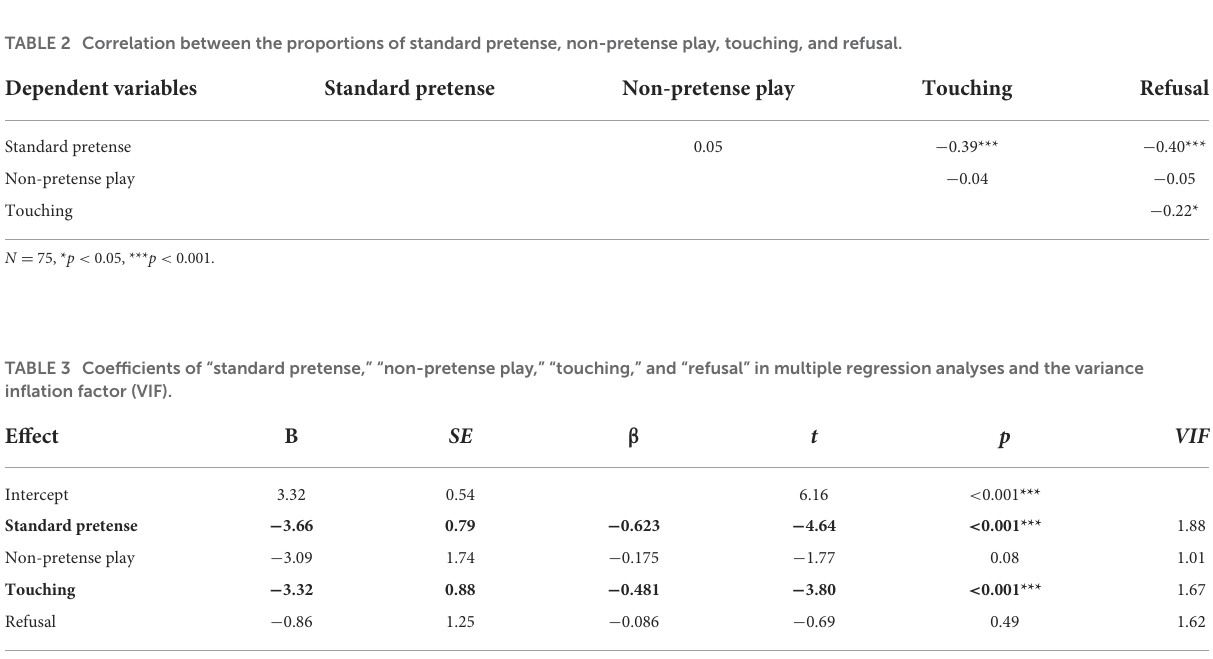
TABLE 1 Children’s mean proportion of each behavioral category during the scale error task period, except for the time exhibiting scale error behavior. Children’s responses SE group ( N = 34) NSE group ( N = 41) Mean SD Standard pretense 0.21 Non-pretense play Touching